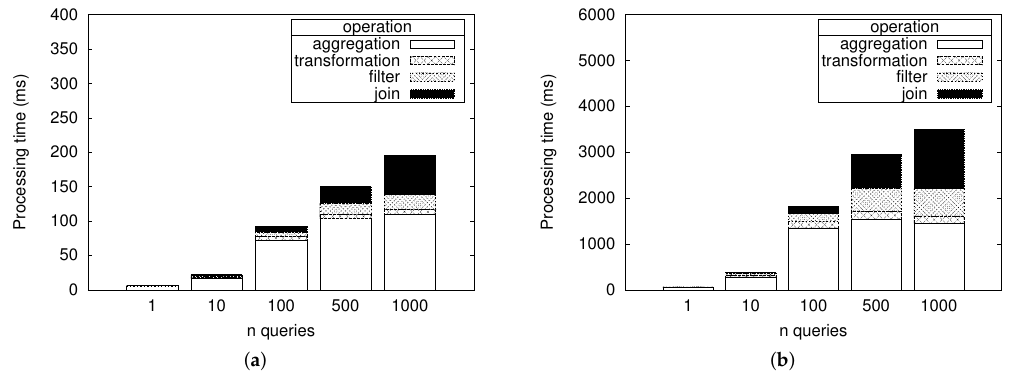
Figure 14. Total processing time for query q 13 for processing 100K of data. ( a ) Infrastructure Node; ( b ) IoT